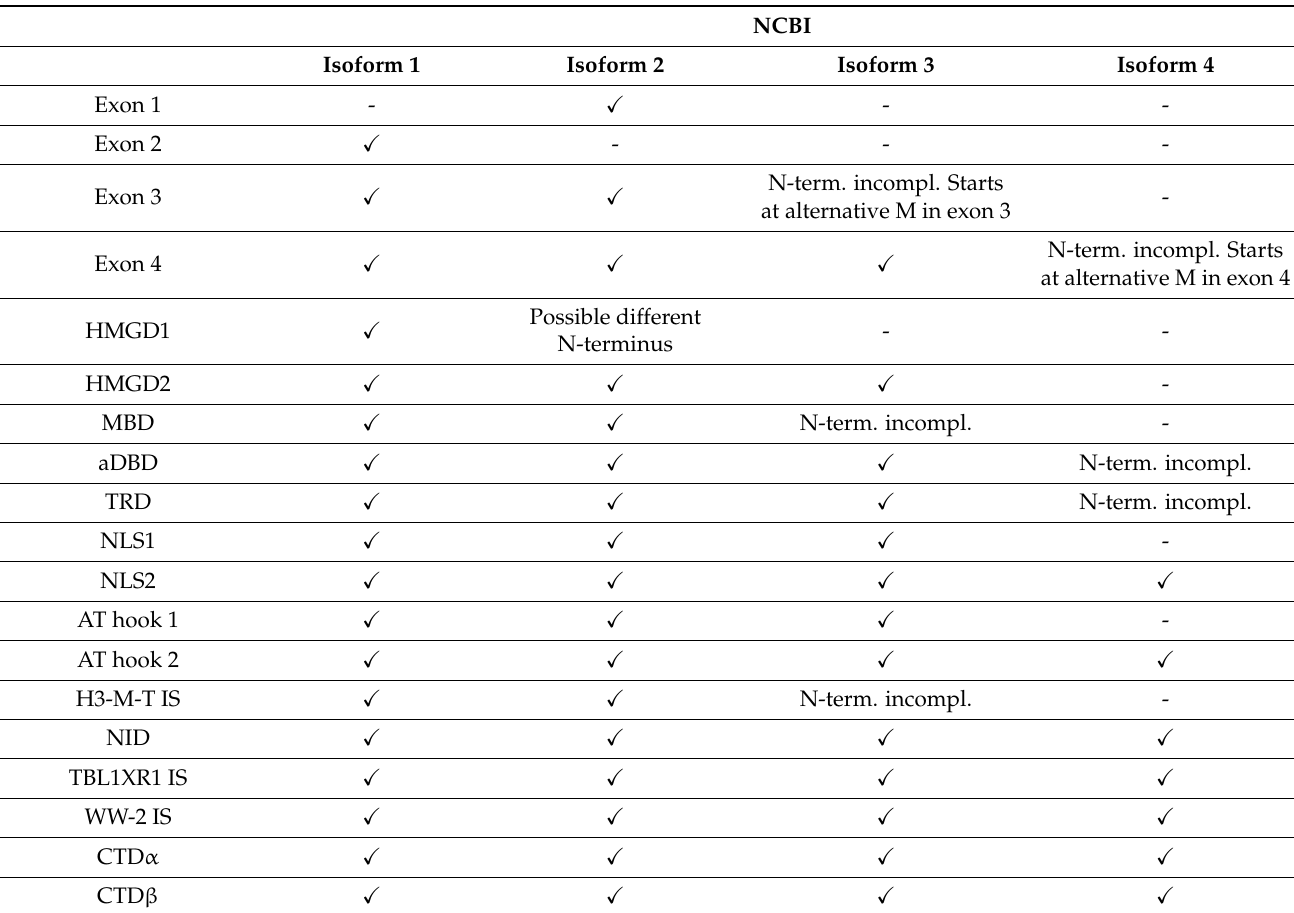
Table 3. Summary of the functional domains present in predicted protein isoforms from NCBI (Updated 15 October 2022).